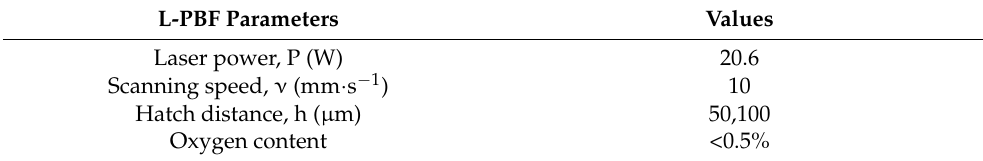
Table 1. The L-PBF parameters used in this